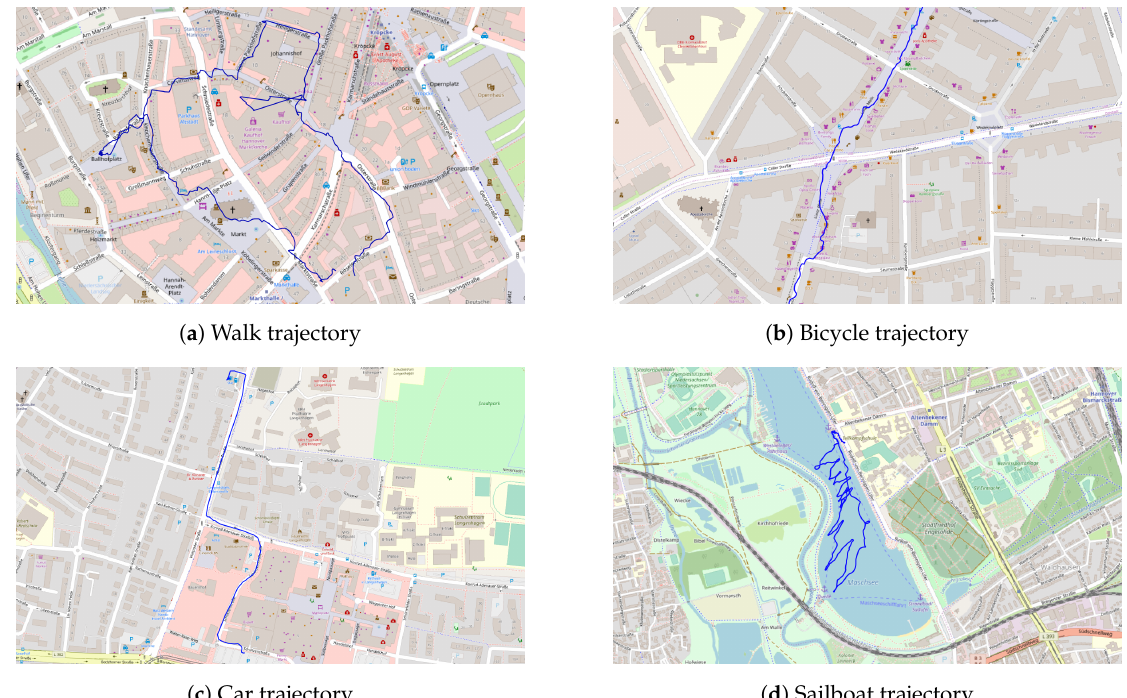
Figure 1. Trajectories from different movement modes: ( a ) walking, ( b ) cycling, ( c ) driving and ( d )